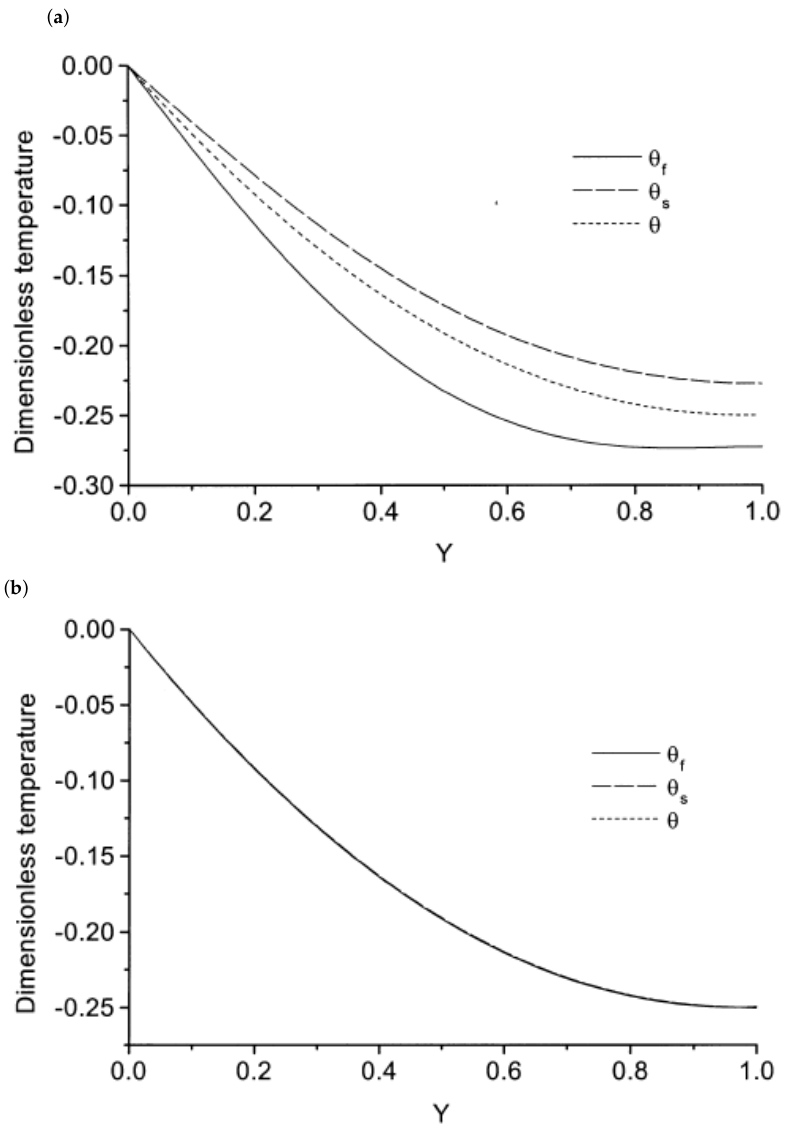
Figure 11. Distributions of fluid temperature ( θ f ), solid temperature ( θ s ), and average temperature ( θ ), using two-equation model, showing the effect of Darcy number for ( a ) Da = 0.1 and ( b ) Da = 0.001, at C = 1, reported by Kim et al.